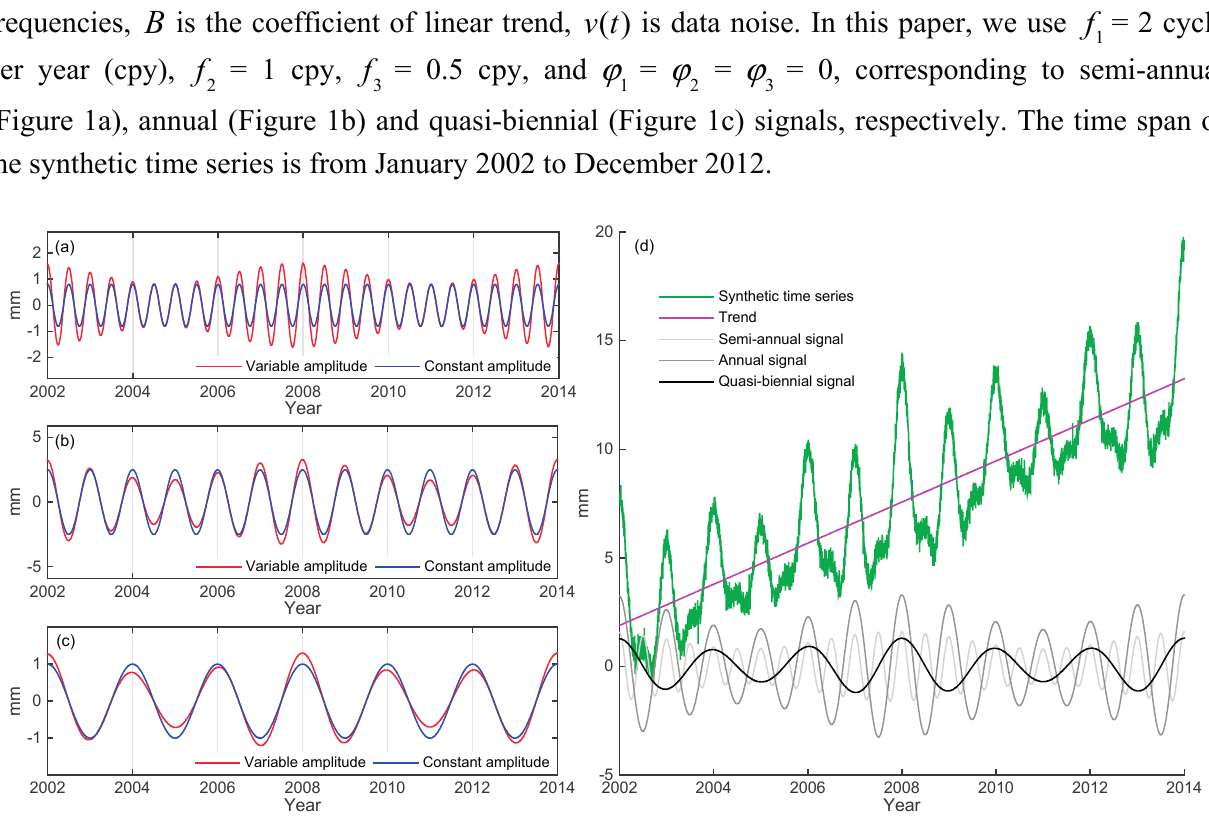
Figure 1. The simulated series (Equation (1), blue), y time-varying (red) amplitudes of frequencies of ( a ) 2 cpy, 1.2 mm ± 0.3 mm; ( b ) 1 cpy, 2.5 mm ± 0.3 mm; and ( c ) 0.5 cpy, 1 mm ± 0.3 mm. ( d ) a new synthetic series (green)